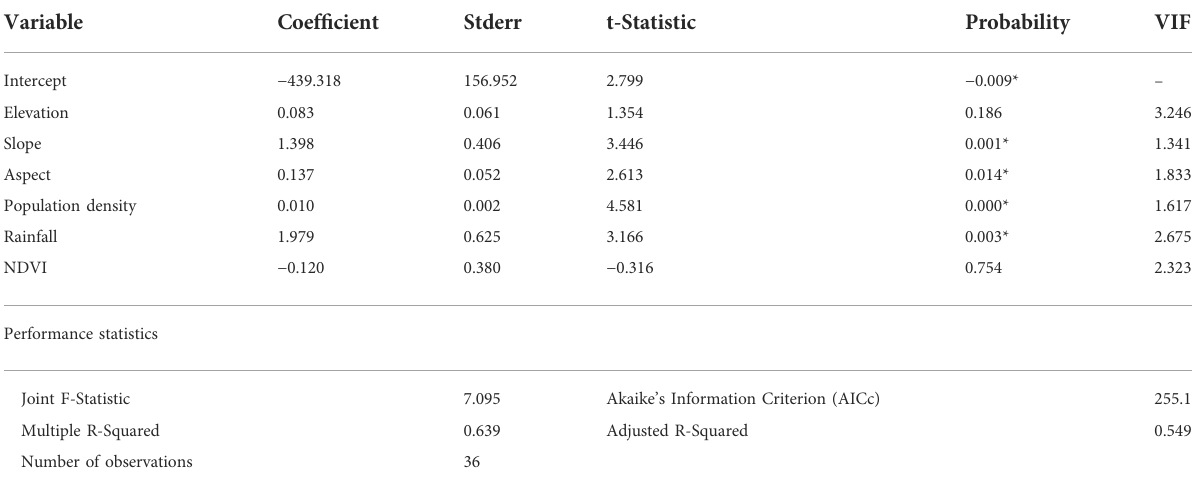
TABLE 4 Summary of OLS results and